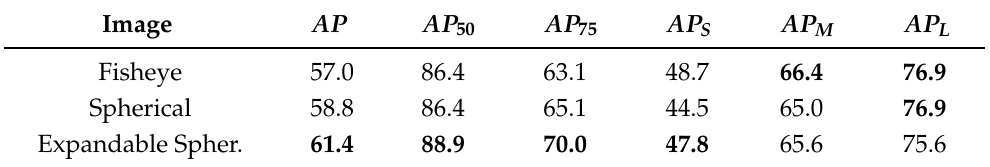
Table 3. Accuracy of different projections of LCat model on the Fisheye-KITTI.